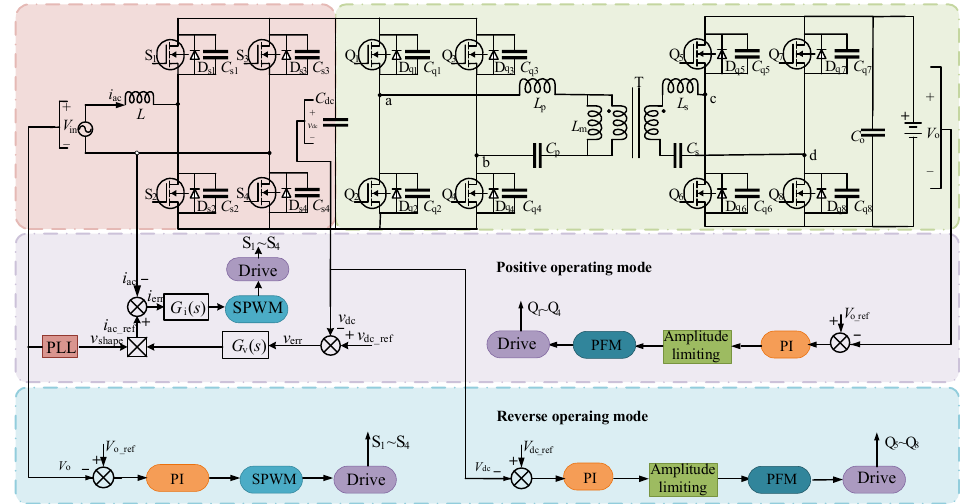
Figure 9. Control strategy of the charging system.